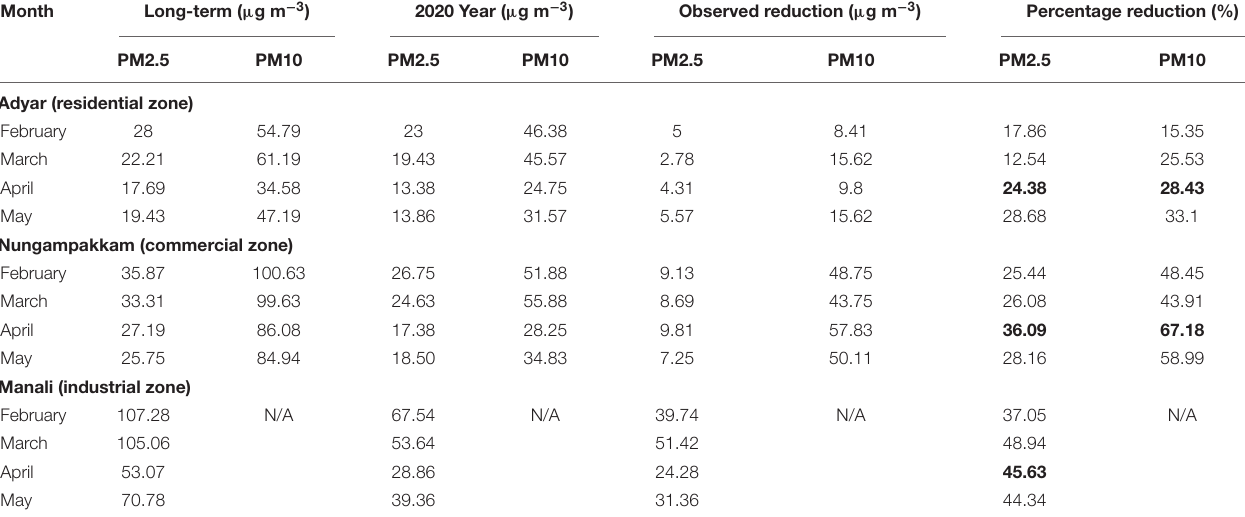
Bold values represent data for April 2020, which is the month considered for analysis.